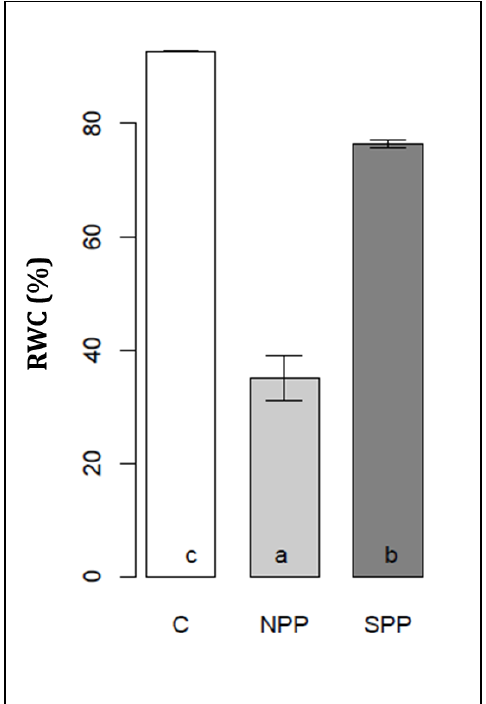
Figure 3. Changes in relative water content (RWC) of primed and nonprimed olive leaves subjected to subsequent drought. Significant differences between the means (at p < 0.05, according to ANOVA) appear with different letters. Values are means ± standard error ( n = 6), where ‘ n ’ is the number of replicates for each group.